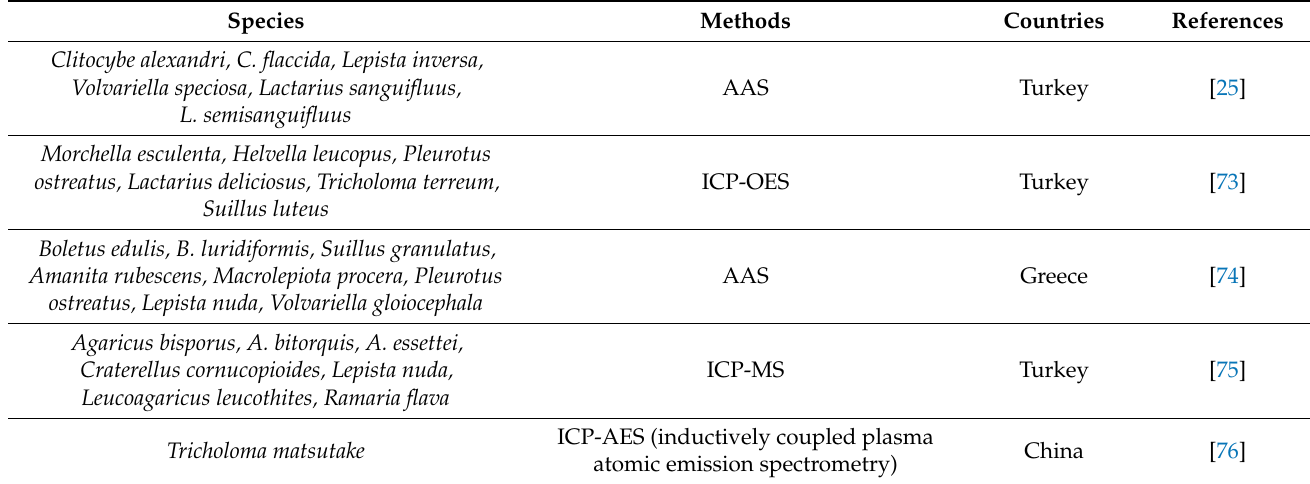
Table 5. Species, methods for determination of manganese, and countries in the literature. Species